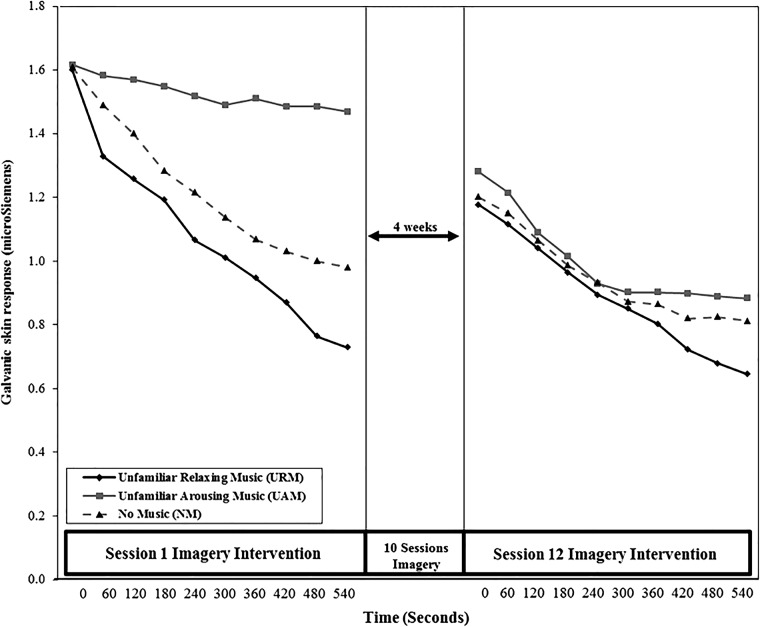
Mean galvanic skin response (GSR) from t0 to t540 across Sessions 1 and 12.